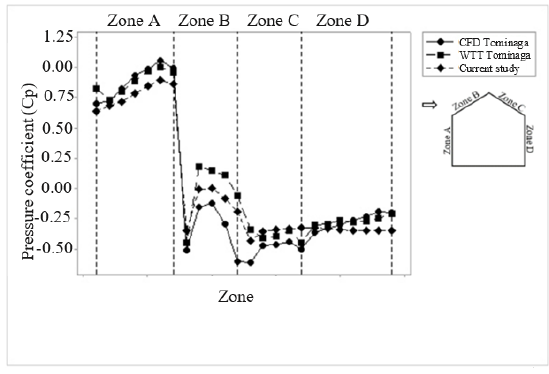
Figure 9. Comparison of pressure coefficients.